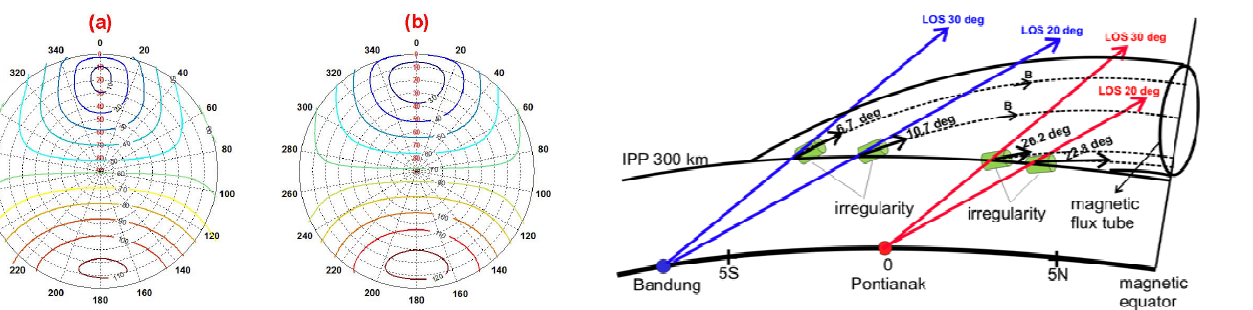
Fig. 10. Geometries between LOS and the magnetic field line at elevation angles of 20 and 30 degrees in the north with respect to Figure 10. Geometries between LOS and the magnetic field line at elevation angles of 20 and3 Figure 10. Geometries between LOS and the magnetic field line at elevation angles of 20 and Figure 10. Geometries between LOS and the magnetic field line at elevation angles of 20 and Bandung and 30 degrees in the North with respect to Bandu4 degrees in the North with respect to Bandung and Pontianak.